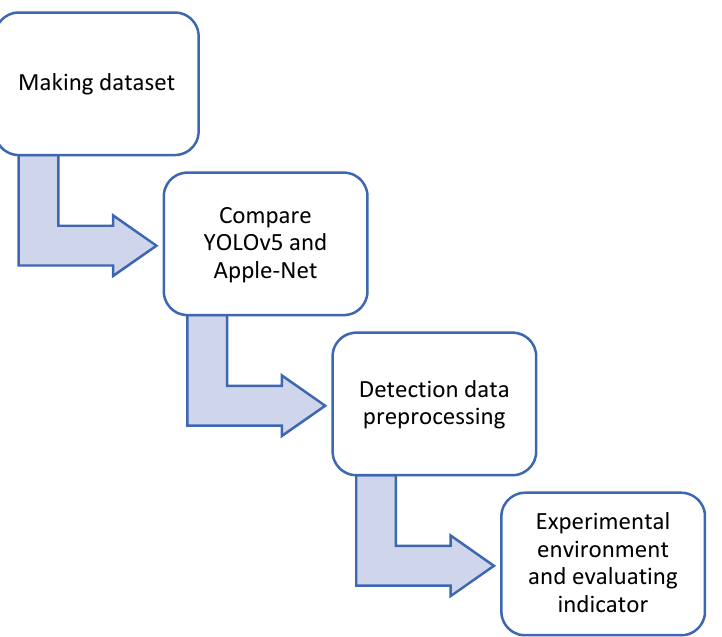
Figure 1. Step flow chart for our research process .